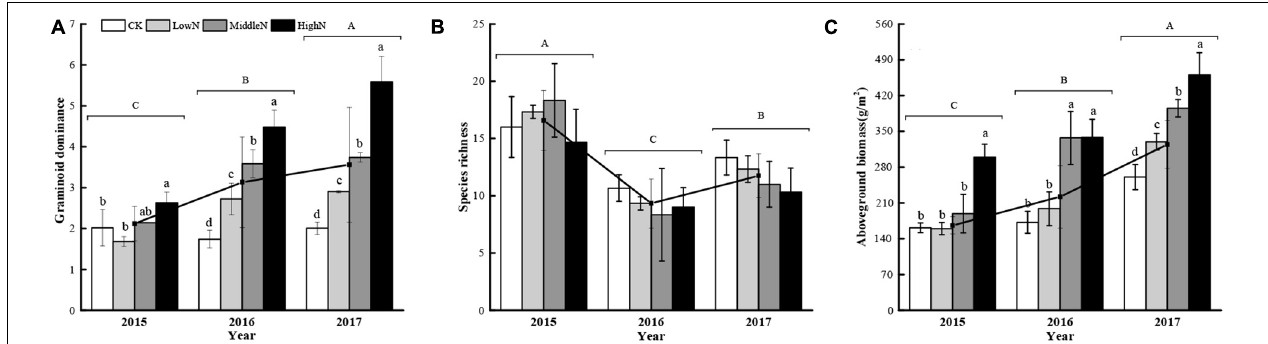
FIGURE 5 | Effects of nitrogen addition rate on (A) graminoid ratio, (B) species richness, and (C) aboveground biomass during the 3-year study. Vertical bars indicate standard deviation of the mean. Lowercase letters indicate significant differences among nitrogen addition rates within years and uppercase letters indicate significant inter-annual differences ( P < 0.05). Functional composition is expressed as the ratio of graminoid cover relative to the cover of non-graminoids (i.e., graminoid dominance). 0 kg N ha − 1 yr − 1 (CK), 8 kg N ha − 1 yr − 1 (LowN), 40 kg N ha − 1 yr − 1 (MidN), and 72 kg N ha − 1 yr − 1 (HighN).